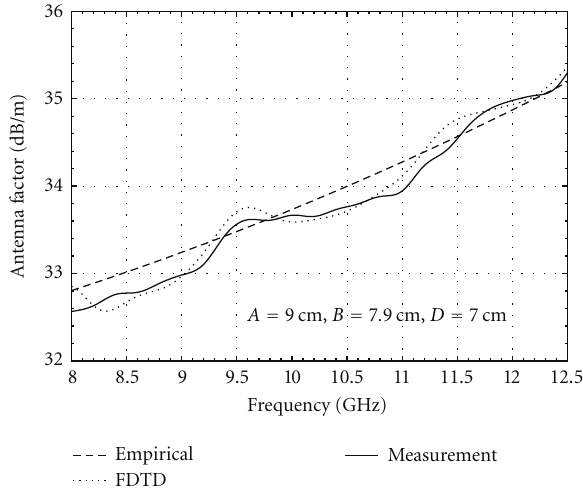
Figure 4: AF of pyramidal horn is computed using FDTD and empirical formula compared with the